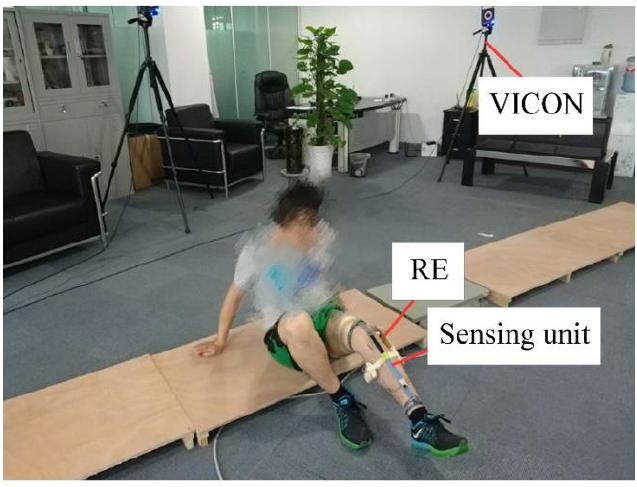
Figure 3. The experiment of knee movement.